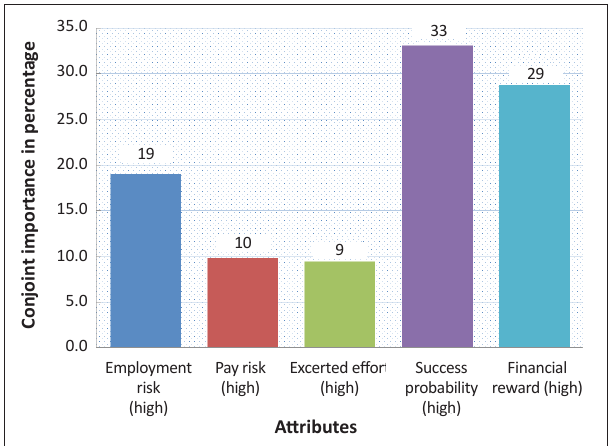
FIGURE 4: Conjoint importances for each